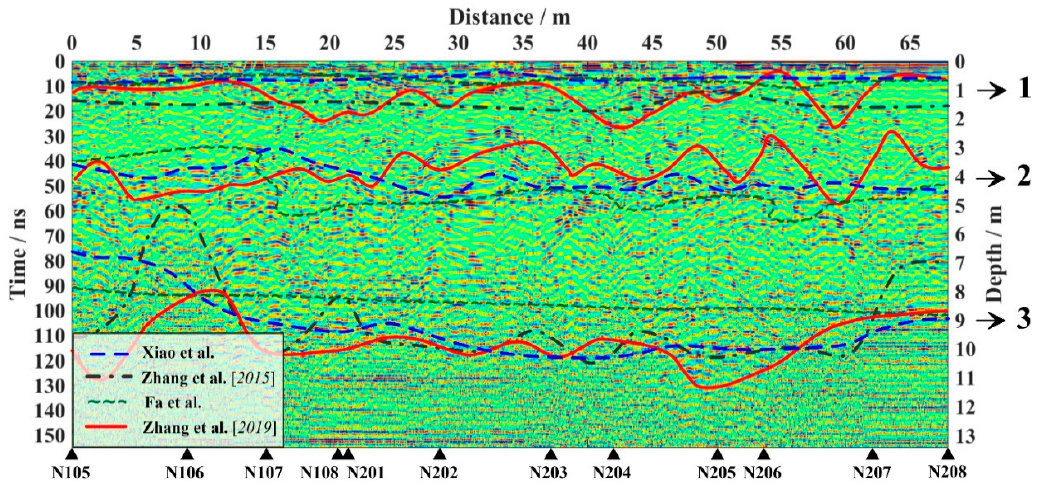
Figure 14. Stratification on CE-3 landing site by CH-2 data.